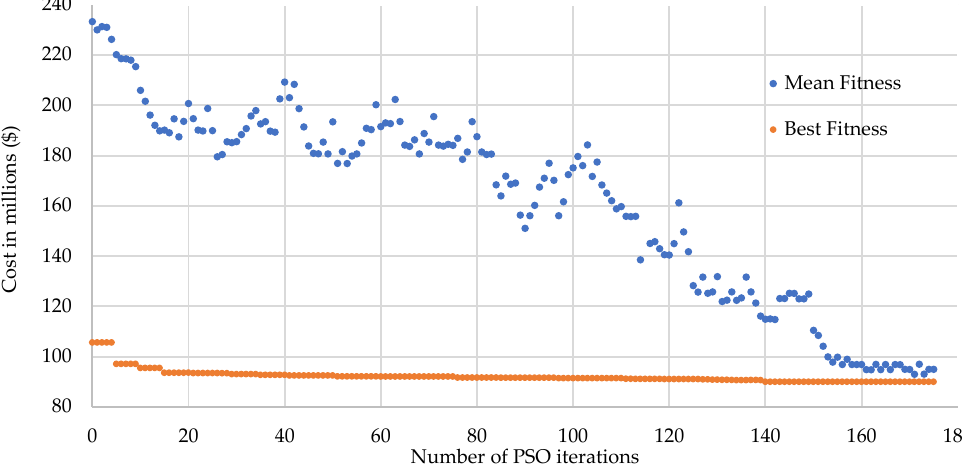
Figure 10. Particle Swarm Optimization (PSO) convergence graph.